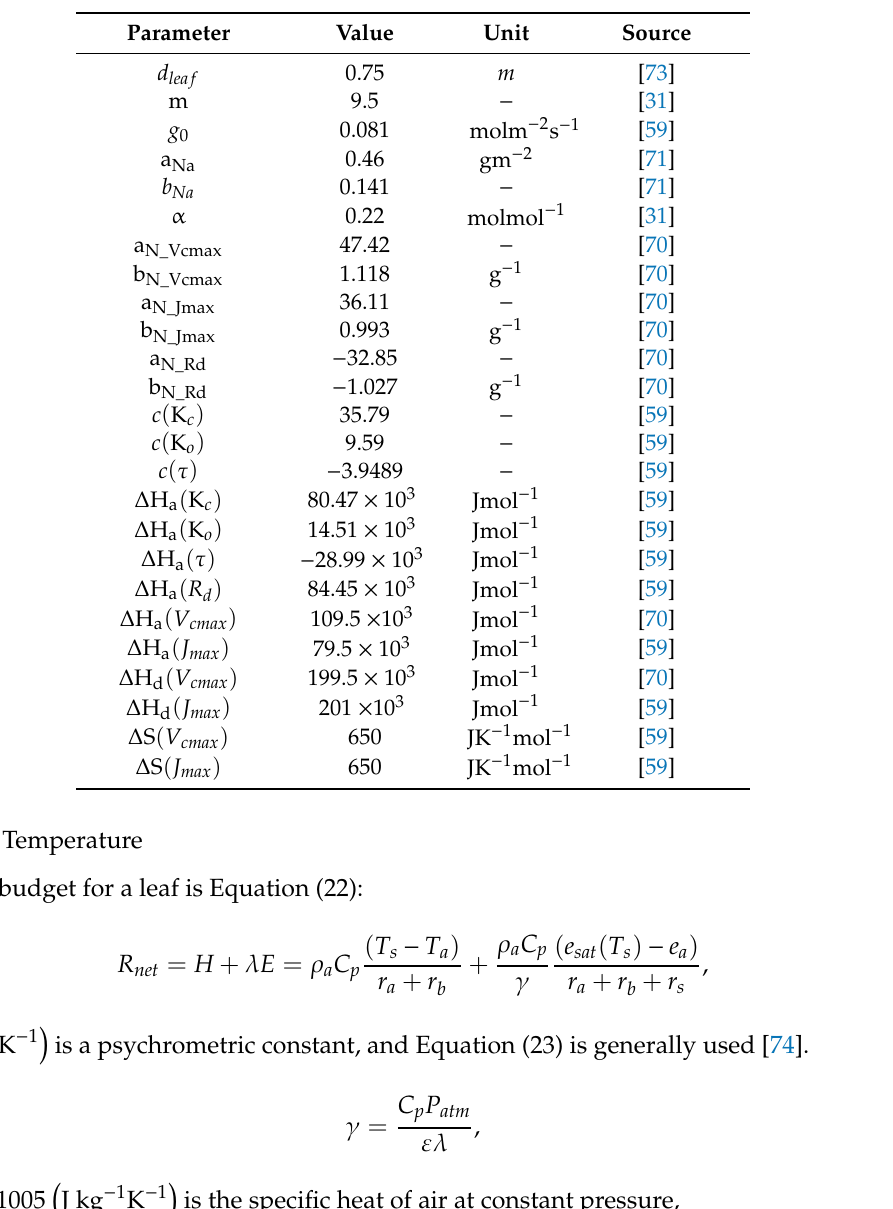
Table 2. Values, units, and sources of the parameters for